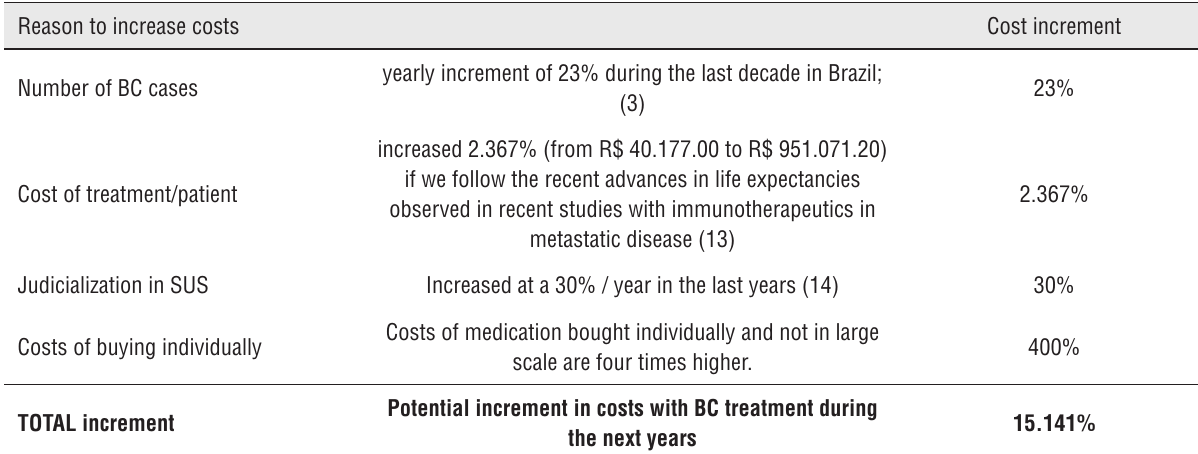
Table 1 - Predicted cost increments on bladder cancer treatment.